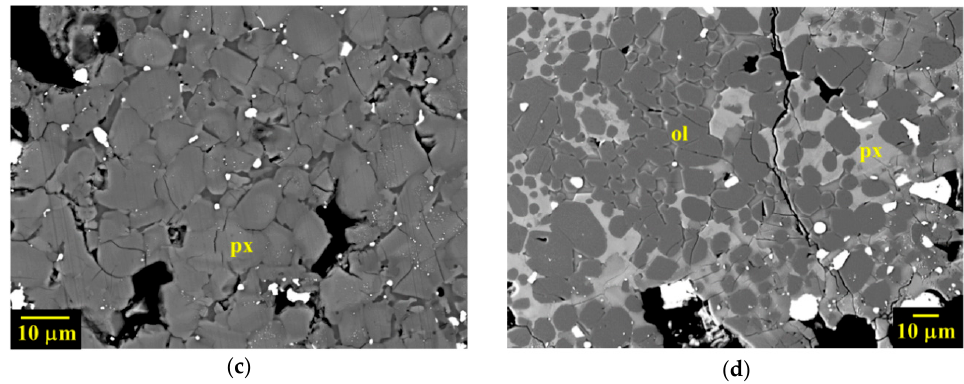
Figure 2. ( a ) Back-scattered electron image (BSE) of AhS #209b, showing the dominant texture of olivine areas (the parallel lines on the surface are polishing scratches). Original olivine (ol) crystals are completely mosaicized to ~5–20 μ m sized equigranular tiles, with minor interstitial Si-Al-enriched glass (gl). ( b ) BSE of less common, impact-smelted olivine area in AhS 209b, with ~5–20 μ m sized equigranular, rounded, grains of reduced olivine with interstitial pyroxenes (px). Metal and sulfide grains (bright) are common. ( c ) BSE of AhS #209b showing impact-smelted pyroxene, consisting of aggregates of ~5–10 μ m sized subhedral grains, with small amounts of interstitial Ca-enriched pyroxenes (px) and Si-Al-enriched glass. Pores and small grains of metal and sulfide (bright) are common. Pyroxenes are reduced relative to inferred primary compositions and show further-reduced outer rims. ( d ) BSE showing dominant lithology in AhS #72, similar to ( b ), of equigranular, rounded, highly reduced olivine with interstitial pyroxene.